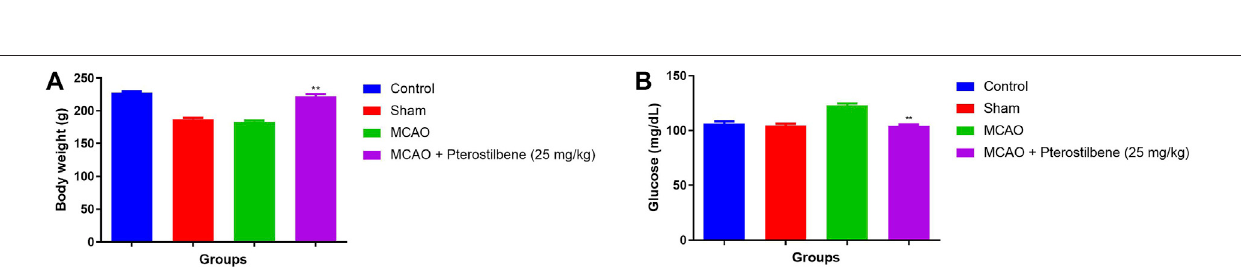
( Figure 10B ), IL-6 (17.04 ± 2.93 pg/mg) ( Figure 10C ) and improved the level of IL-10 (28.34 ± 1.83 pg/mg) ( Figure 10D ).